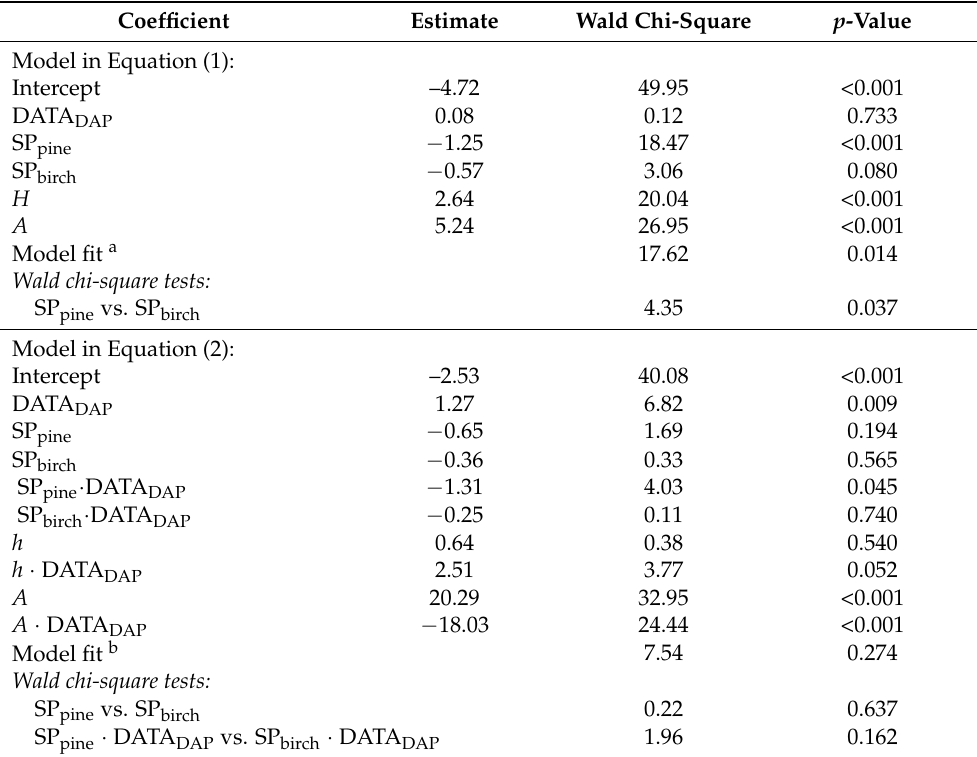
Table 7. Estimation results for logistic regression models shown in Equations (1) and (2) ( n = 2 × 530).